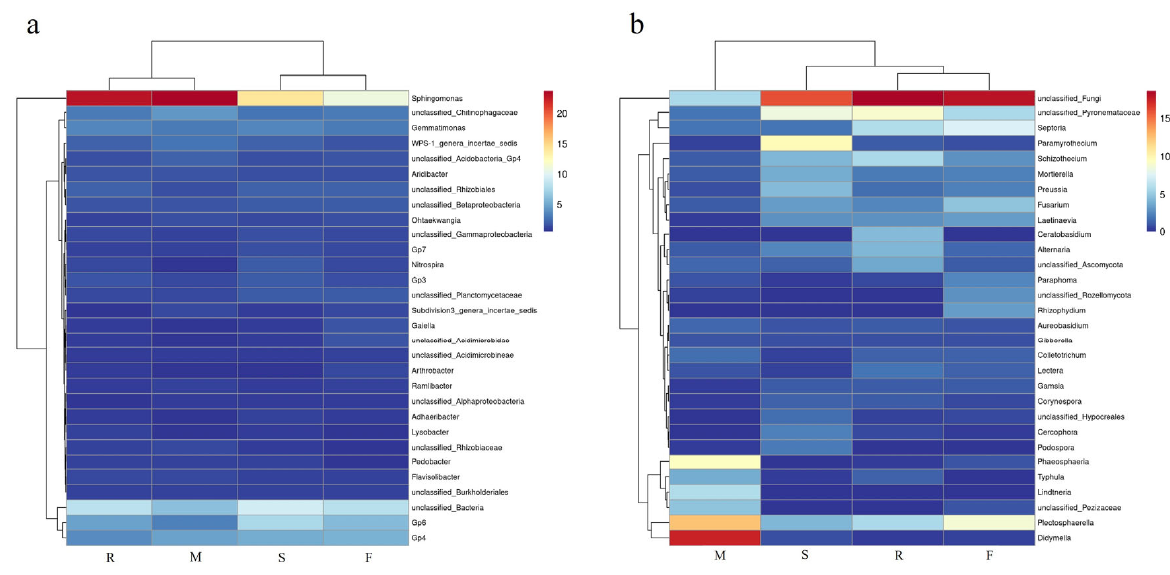
Figure 3. Microbial community-related heatmap and cluster analysis of the bacterial ( a ) and fungal ( b ) community composition at the genus level. S, R, F, and M represent the seedling stage, rapid growth stage, flowering stage, and maturity stage,